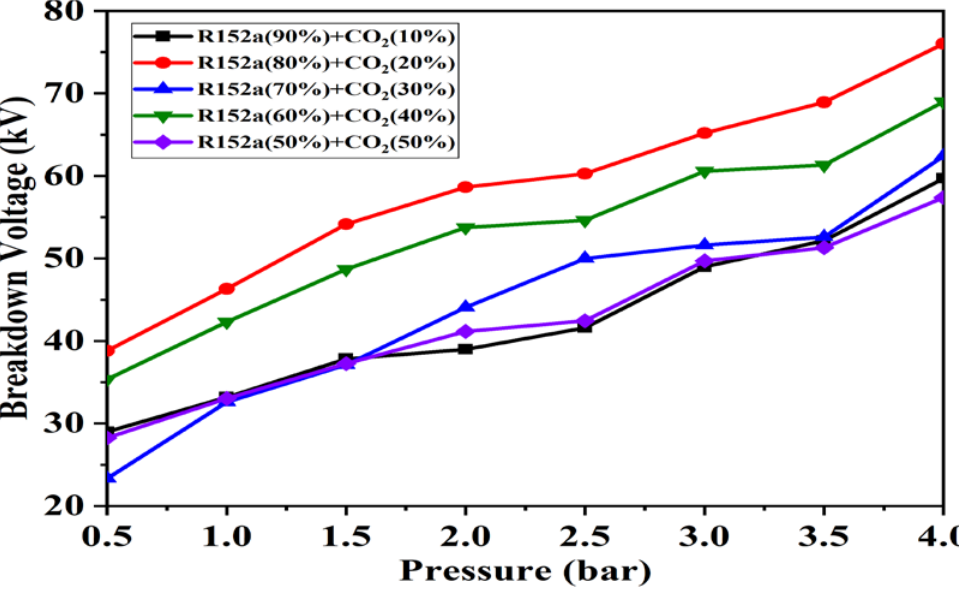
Figure 3. AC power frequency breakdown voltage of R152a / CO 2 gas at varying mixture ratio and 8 mm electrode gap distance.